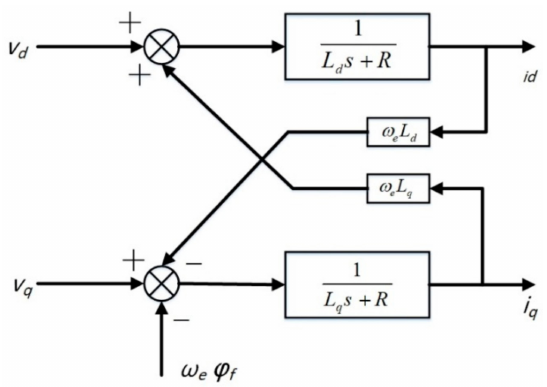
Figure 4. Dynamic block diagram of the